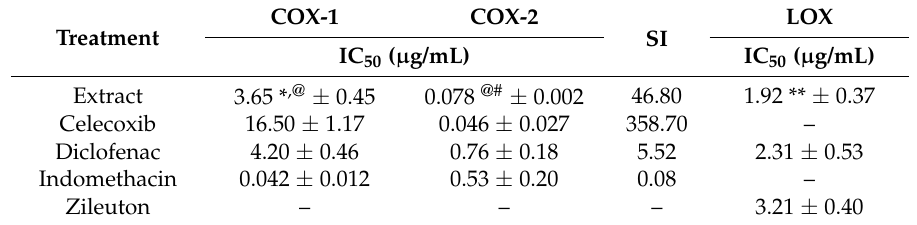
Table 3. Effect of A. zerumbet extract on the activities of COX-1, COX-2, and LOX enzymes, calculated as extract concentration that caused 50% inhibition of enzyme activity (IC 50 ). Celecoxib, diclofenac, indomethacin, and zileuton were used as positive controls.